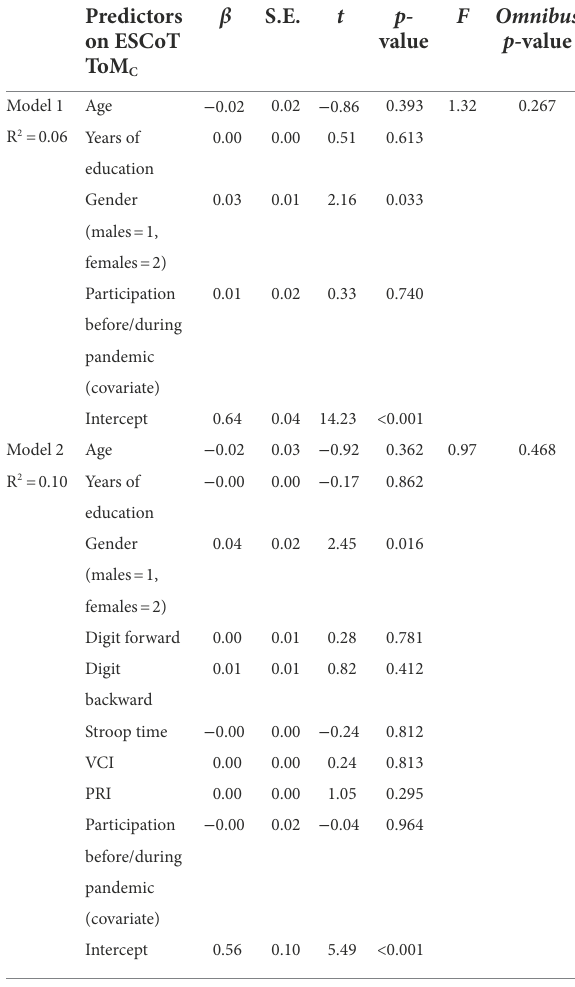
TABLE 3 Multiple regression results for predictors of ESCoT total